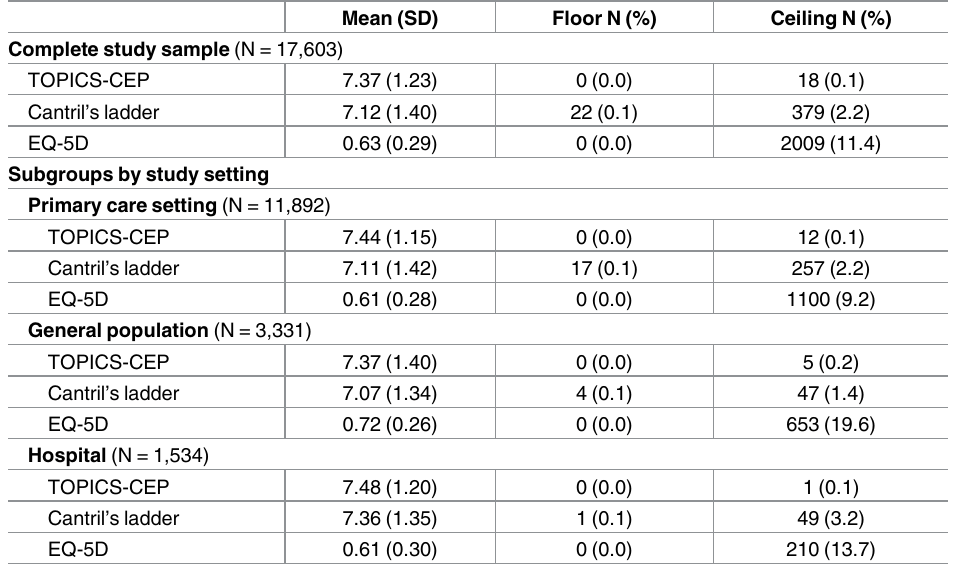
Table 1. The mean ( ± SD)scores and floor and ceiling effectsfor the complete sample and stratified by subgroup. Mean (SD) Floor N